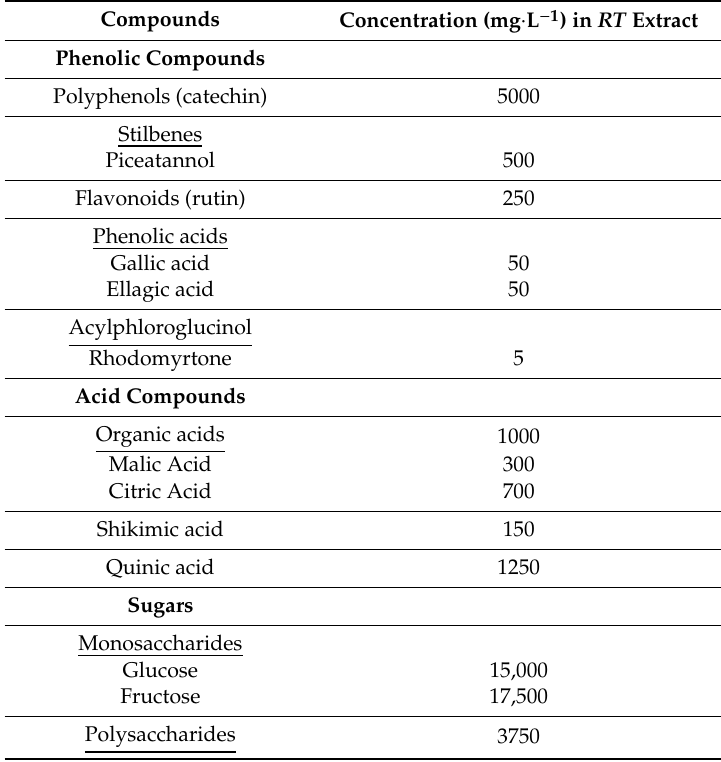
Table 1. Characterization of Rhodomyrtus tomentosa ( RT )